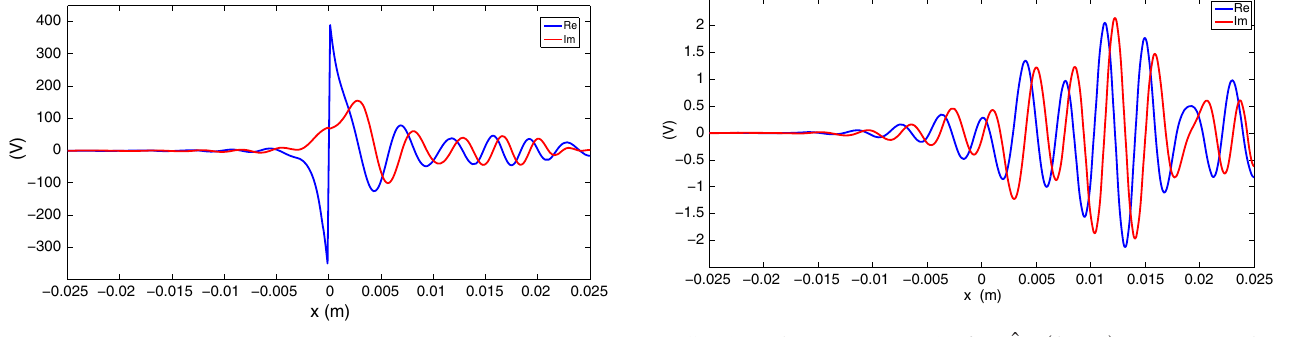
ˆ H k; s; x Þ at y ¼ 0 , at the end yp ð